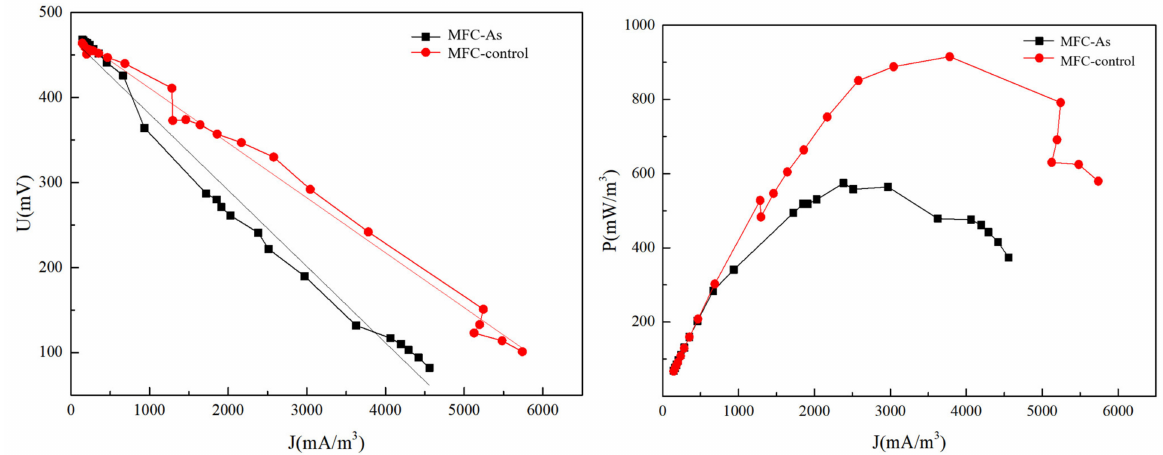
Figure 3. Power density and polarization curve during stable operation of the